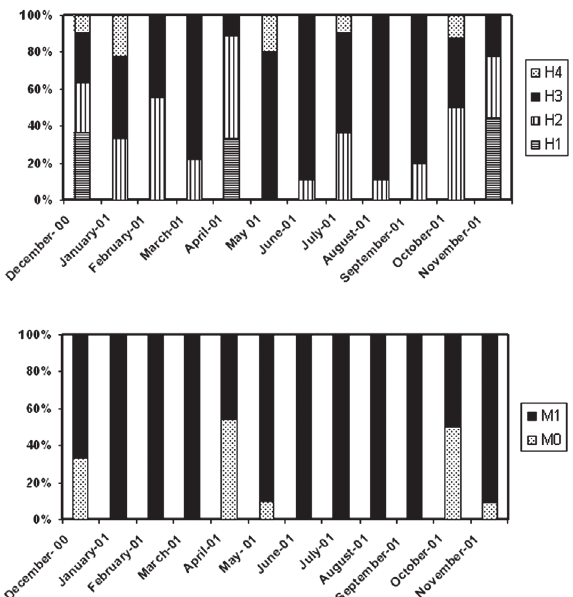
Fig . 5 . – temporal trends of the percentage for each gonadal stage at torremuelle. (a) Females; h1, spent condition; h2 phase of oocyte maturation; h3, mature state with ova; h4, phase of gonadal recon- stitution with maximum thickness of the nutritive layer. (B) Males; M0, spent condition; M1, mature gonad with sperm.